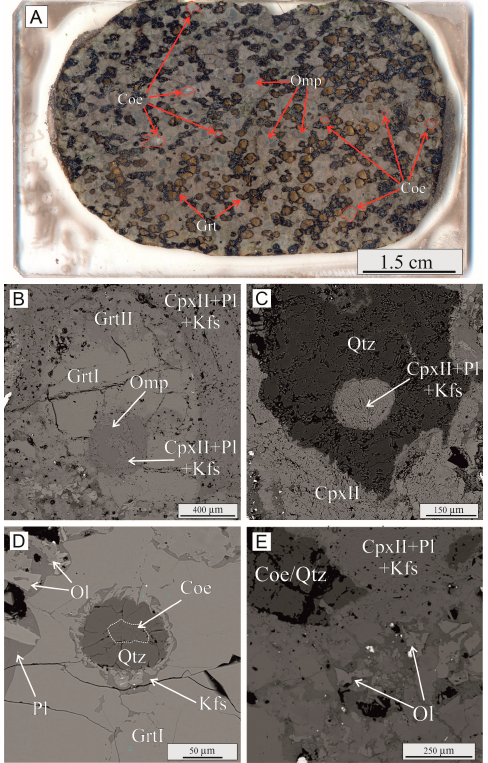
Figure 1. Photomicrograph of polished section ( A ) and BSE images ( B – E ) of sample Uv-537. ( A ): xenolith composed of garnet (Grt), omphacite (Omp, i.e., CpxI) and coesite/quartz (Coe/Qtz); ( B ): garnet grain (Grt I–garnet core, Grt II–garnet rim) with inclusions of primary clinopyroxene and secondary mineral assemblages after omphacite (CpxII–secondary clinopyroxene, Pl–plagioclase, Kfs–K-feldspar); ( С ): quartz (Qtz) grain with an inclusion of secondary clinopyroxene, plagioclase and K-feldspar; ( D ): coesite (Coe) inclusion in garnet with quartz rim and a secondary mineral assemblage (Ol–olivine); ( E ): interstitial olivine and coesite/quartz grains.